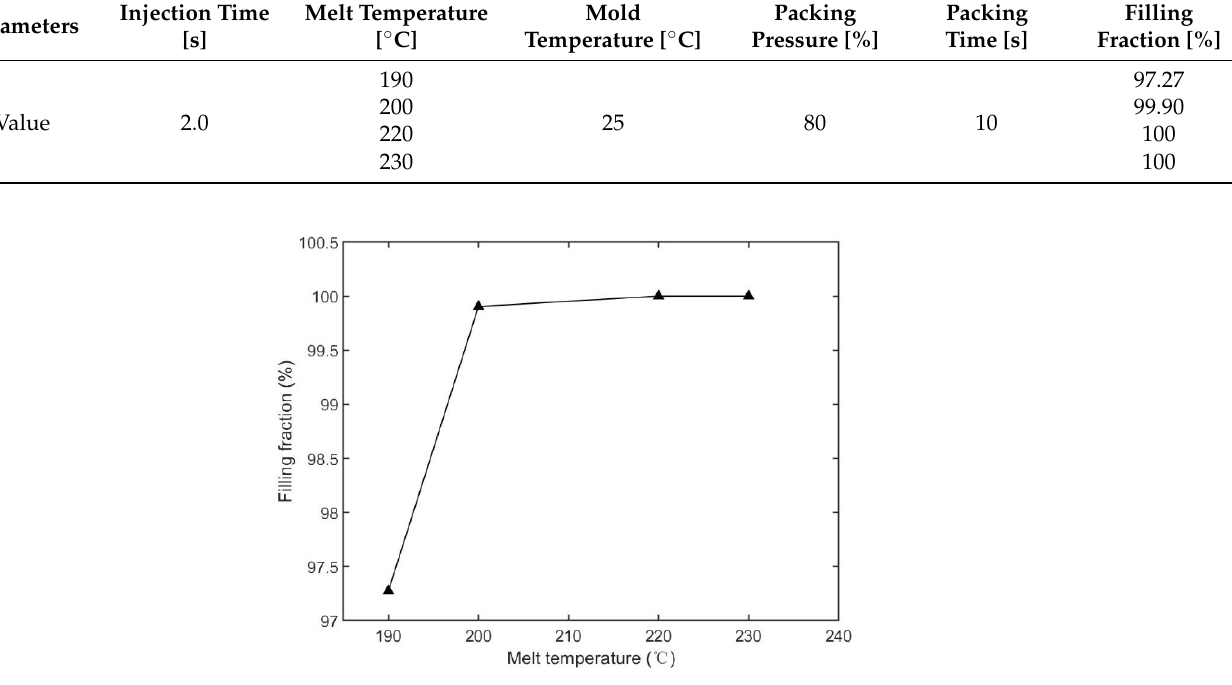
Figure 6. Filling contours for different melt temperature cases.